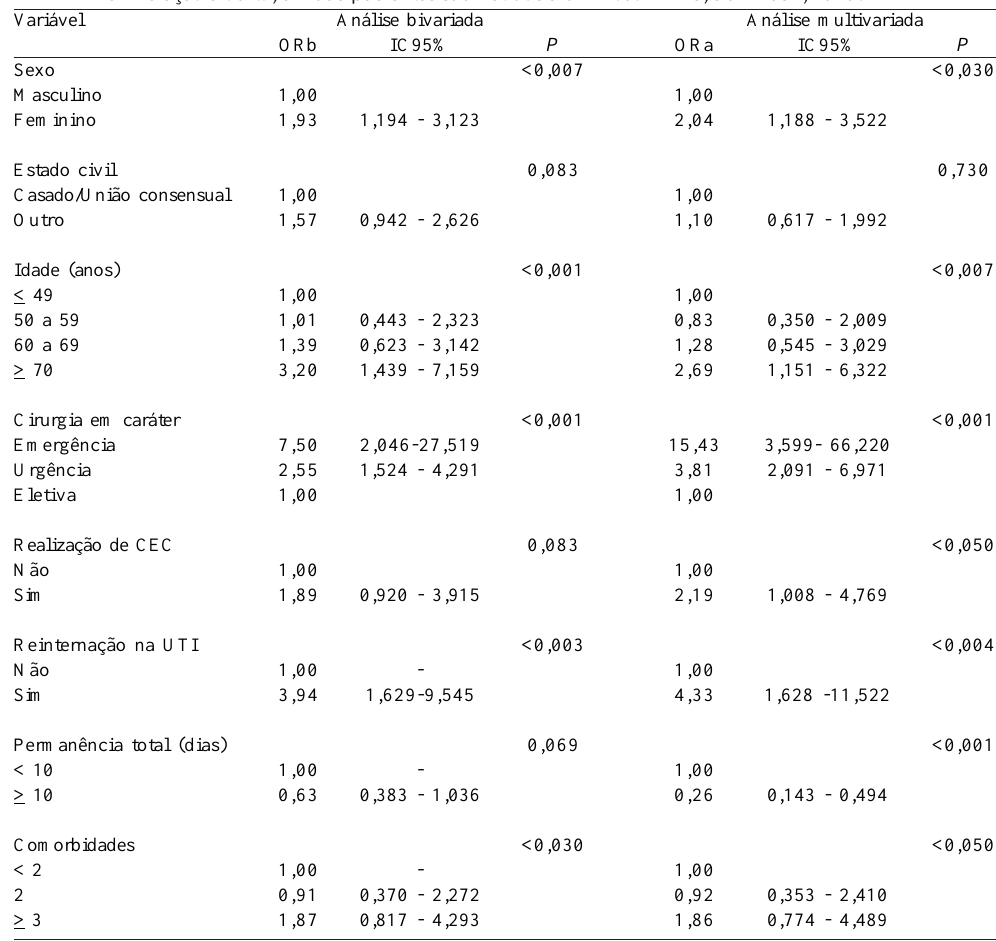
Tabela 4. Resultados da regressão logística simples e múltipla, tendo como desfecho a evolução hospitalar: